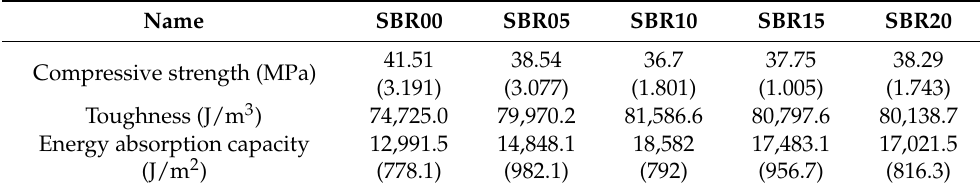
Figure 4. Constitutive curves of the SBR latex-modified cement paste at 28 days. Table 3. Results from the compressive strength test and the Charpy impact test at 28